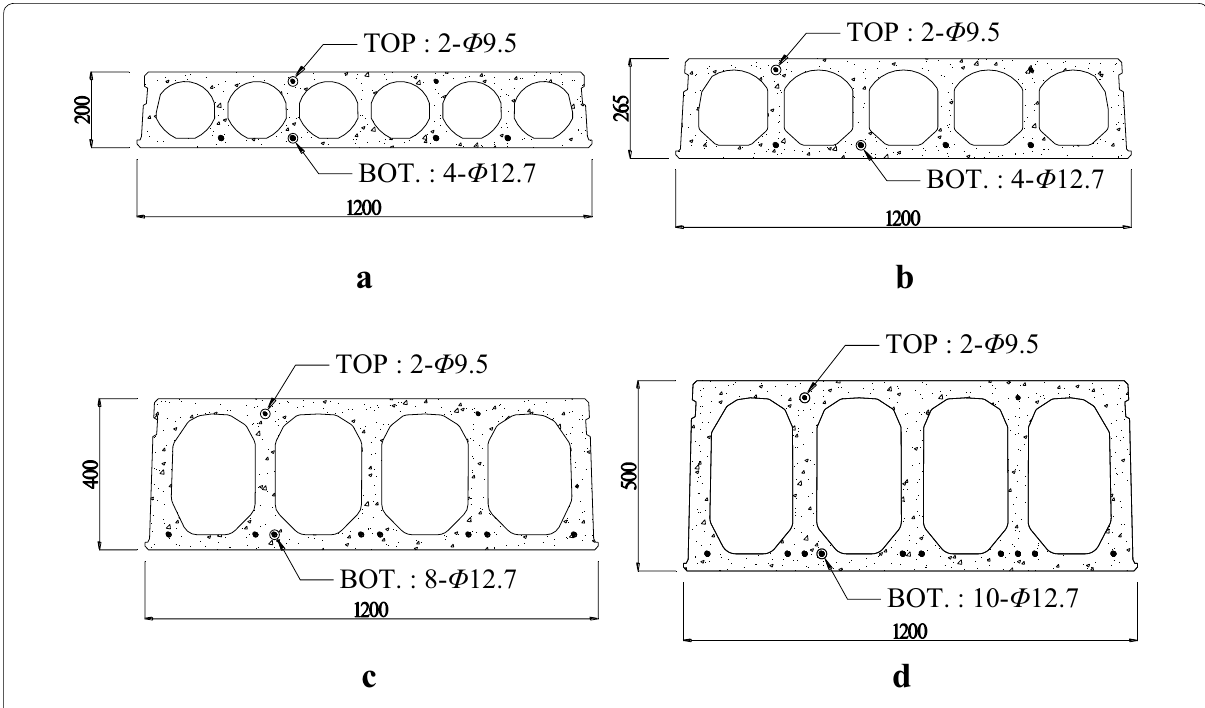
Fig. 4 Dimensional details of test specimens. a S2 series, b S2.65 series, c S4 series, d S5 series (Unit: mm).